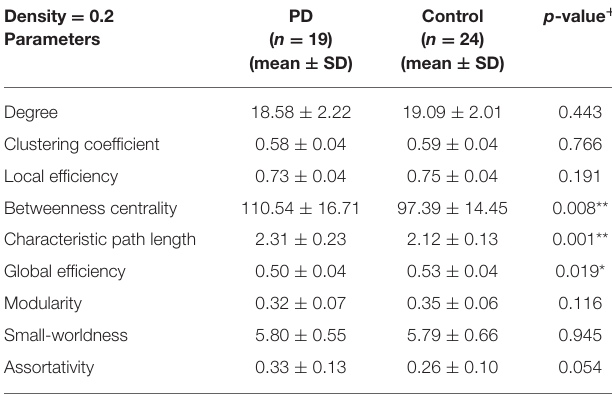
TABLE 2 | Comparison of parameters from graph analysis. Density = 0.2